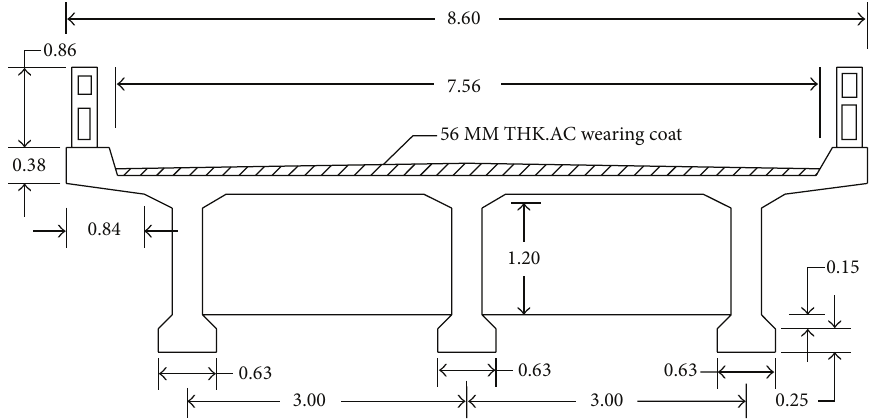
Figure 3: Cross-section of T-beam bridge (all dimensions are in meter).